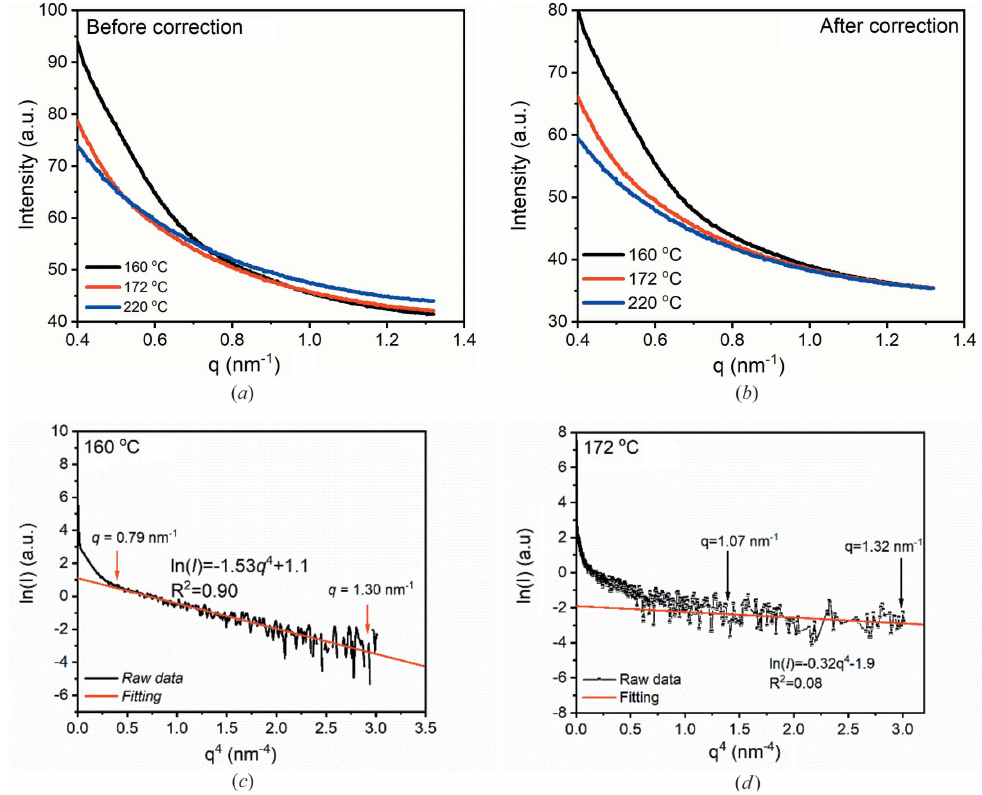
Figure 6 Scatterings at 160, 172 and 220 (cid:3) C, ( a ) before and ( b ) after correction. Plots of ln( I ) and q 4 at ( c ) 160 and ( d ) 172 (cid:3)